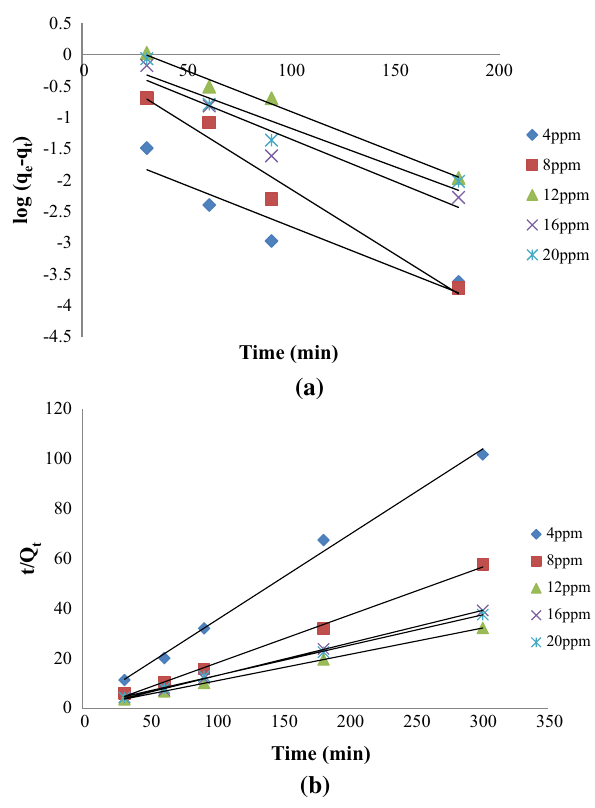
Fig. 5 a Pseudo-first-order and b Pseudo-second-order kinetic studies